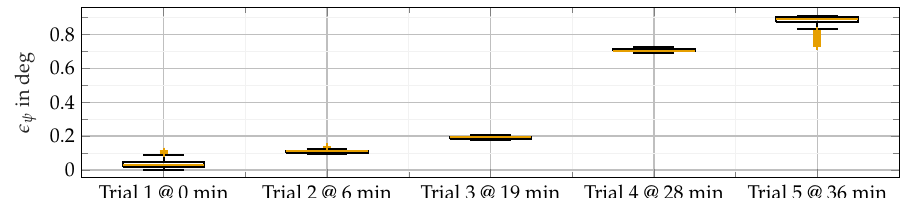
Figure 7. Statistical analysis of heading angle error (cid:101) ψ .